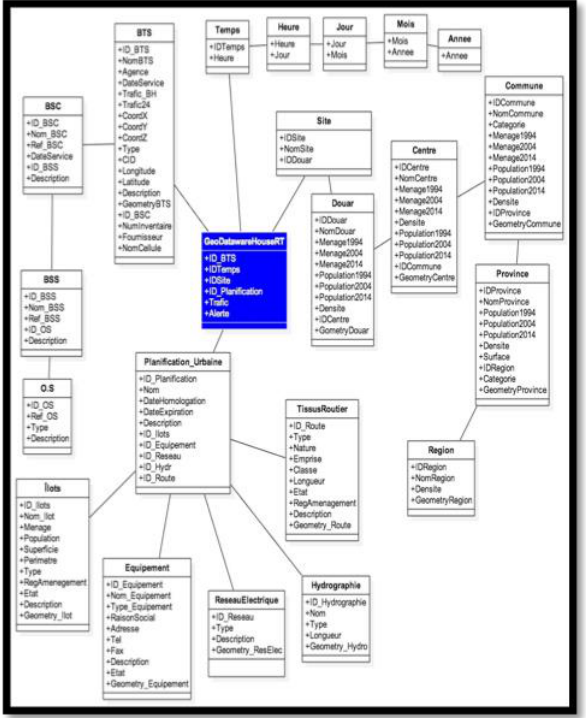
Figure 4 The model of our Data warehouse (Figure 4) is represented by the fact table (blue table) which contains the necessary information (Measure) in the description of a mobile network such as